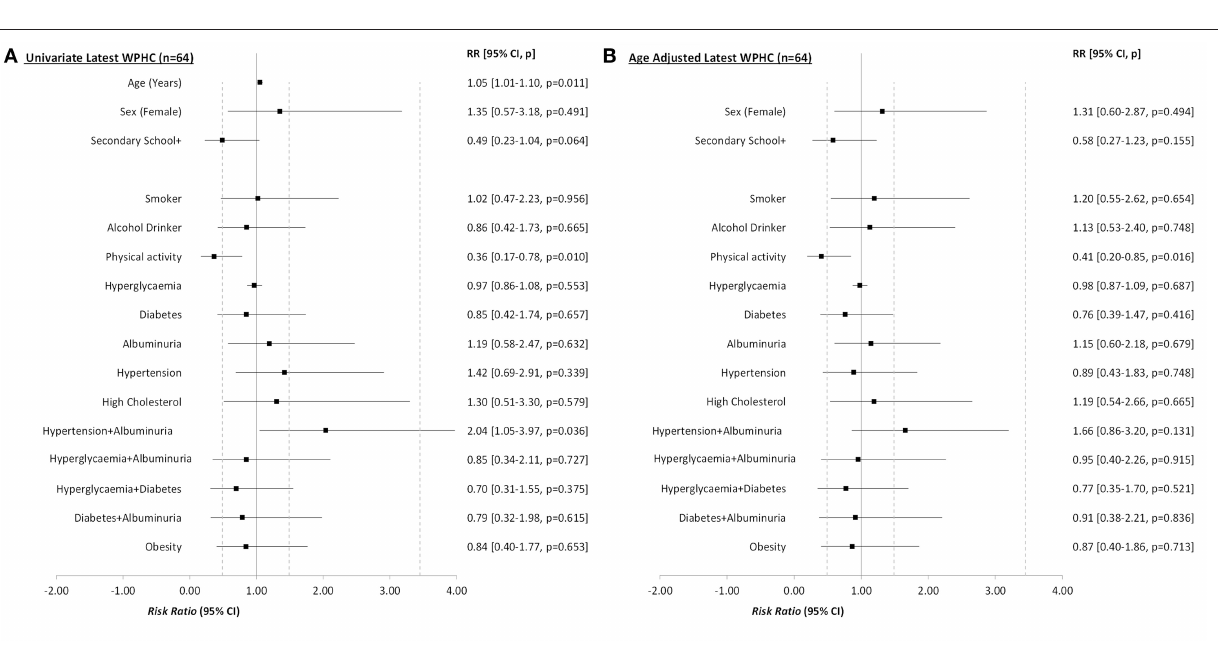
, Highest education is secondary school or further. + data limited to participants aged < 60 years at the time of baseline assessment, to examine the potential effect of older participants at